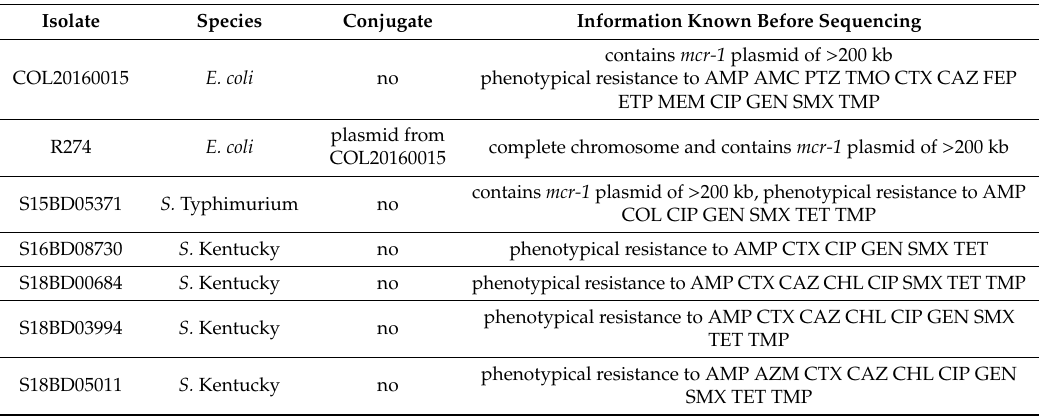
Table 7. Characteristics of isolates used in this